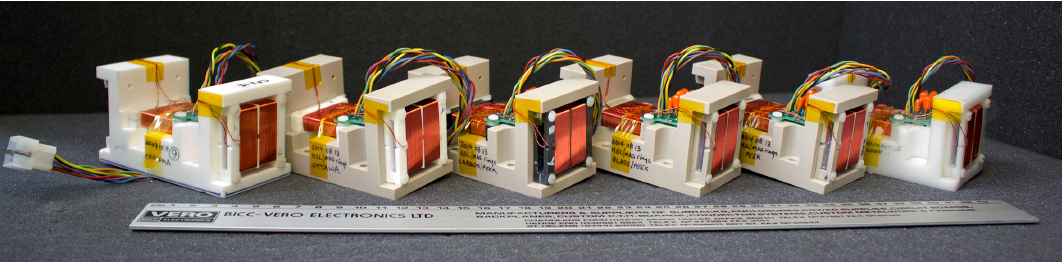
Figure 6. Fluxgate sensors used in this experiment: (left to right) MACOR bobbin/MACOR base, MACOR bobbin/PEEK base, carbon PEEK bobbin/PEEK base, glass PEEK bobbin/PEEK base, PEEK bobbin/PEEK base, and acetal bobbin/acetal base. Note the various colours of material used in the winding bobbins and the base. For example, third from left is carbon PEEK bobbin/PEEK base, distinguished by charcoal-coloured bobbins. The 914.4mm ruler is included for scale.